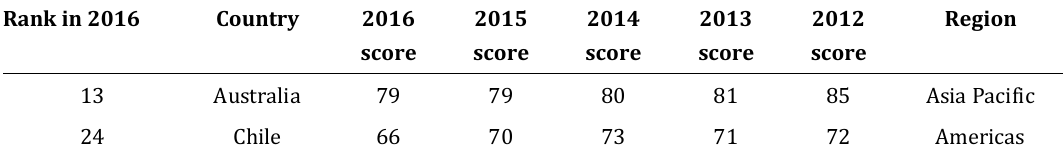
Table 1: Corruption Perceptions Index